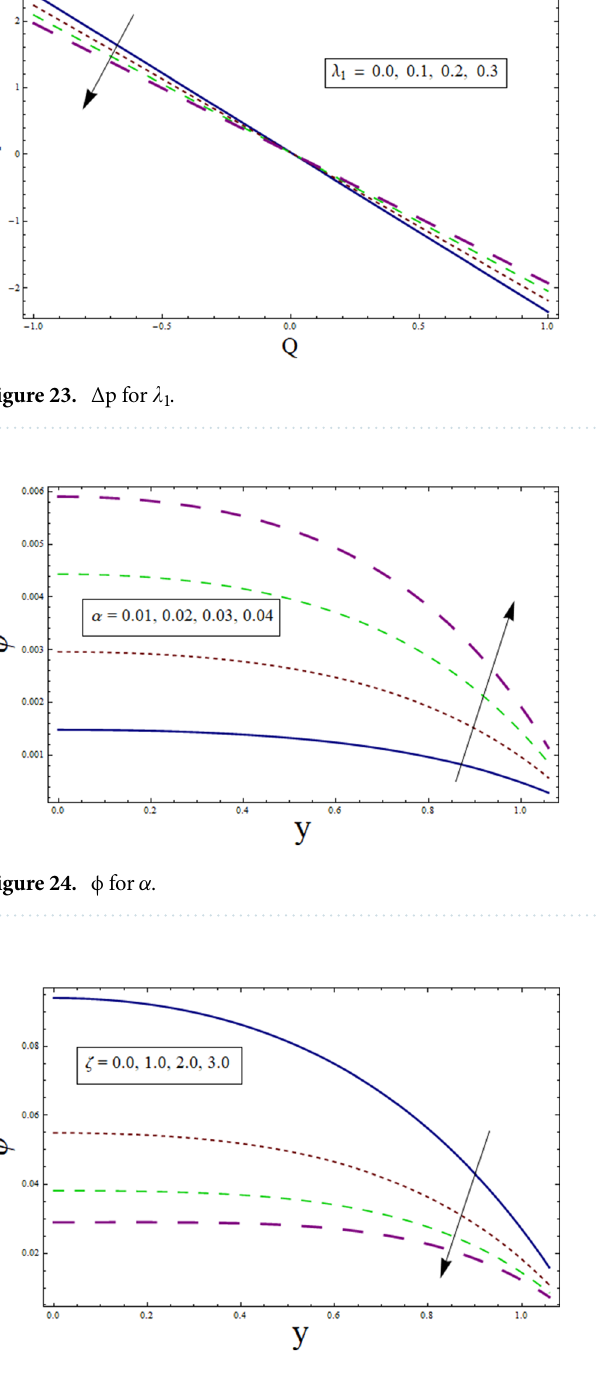
Figure 25. ϕ for ξ